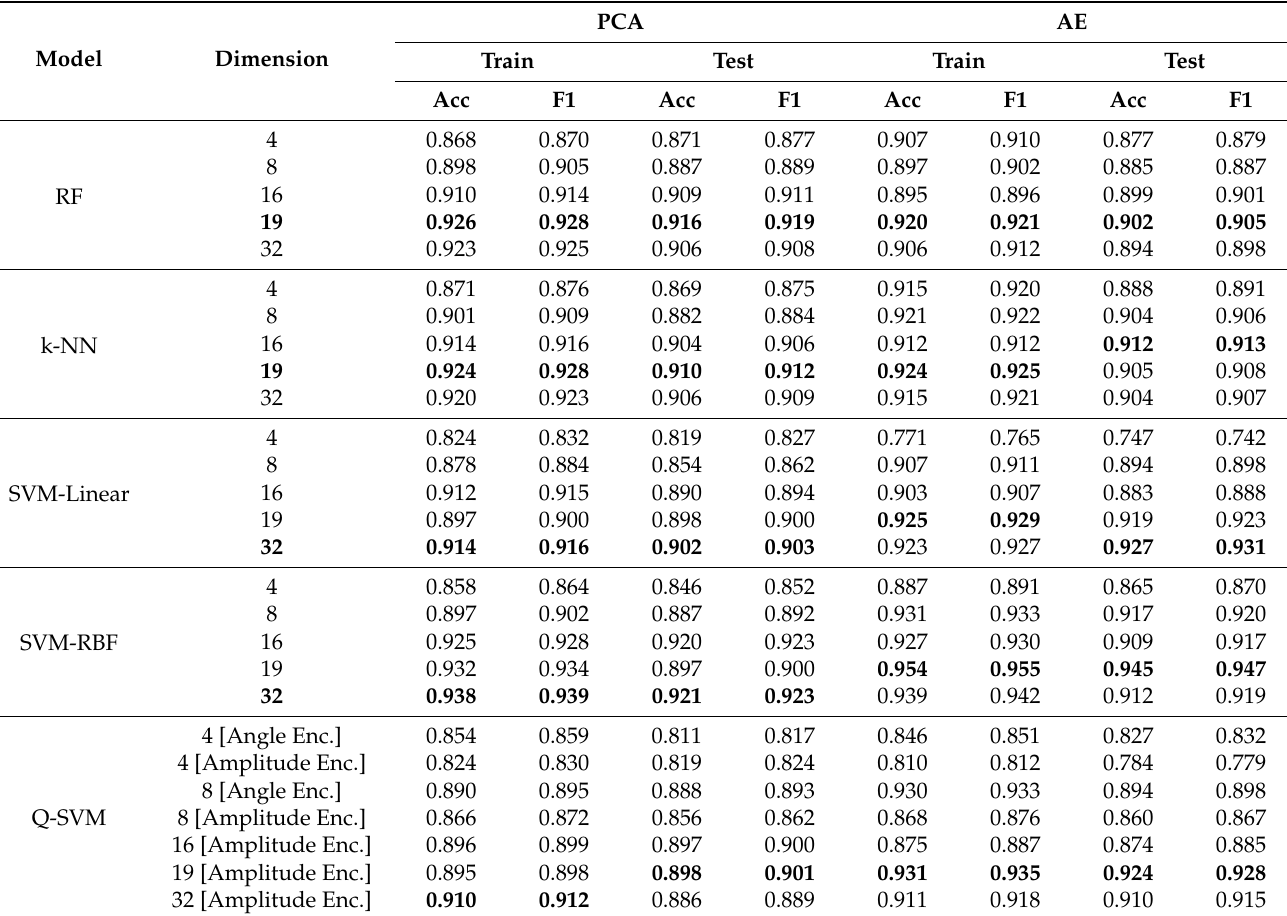
Table 7. Diagnostic model metrics using data preprocessed through PCA and